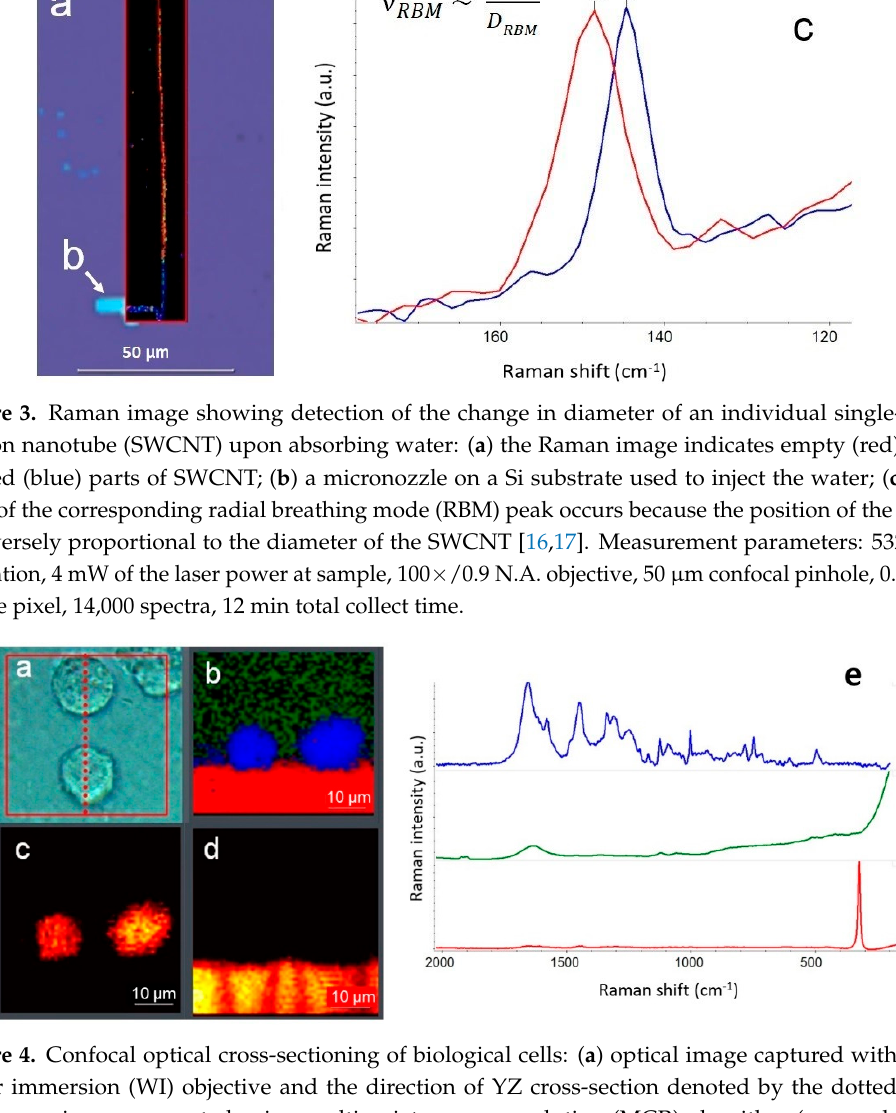
Figure 4. Confocal optical cross-sectioning of biological cells: ( a ) optical image captured with 60× water immersion (WI) objective and the direction of YZ cross-section denoted by the dotted line; ( b ) Raman image generated using multivariate curve resolution (MCR) algorithm (green — buffer, blue — lipids, red — CaF 2 substrate); ( c ) YZ Raman image generated as integral area of the band at 2925 cm − 1 assigned to lipids; ( d ) YZ Raman image generated as integral area of the peak of CaF 2 at 320 cm − 1 ; ( e ) average representative Raman spectra of the cell (blue), buffer (green) and CaF 2 substrate (red) in the “fingerprint” region — the spectra are normalized and offset for clarity. Measurement parameters: 532 nm excitation, 10 mW of the laser power at the sample, 50 µm confocal pinhole, 0.8 µm image pixel, 2500 spectra, 10 min total collect time.